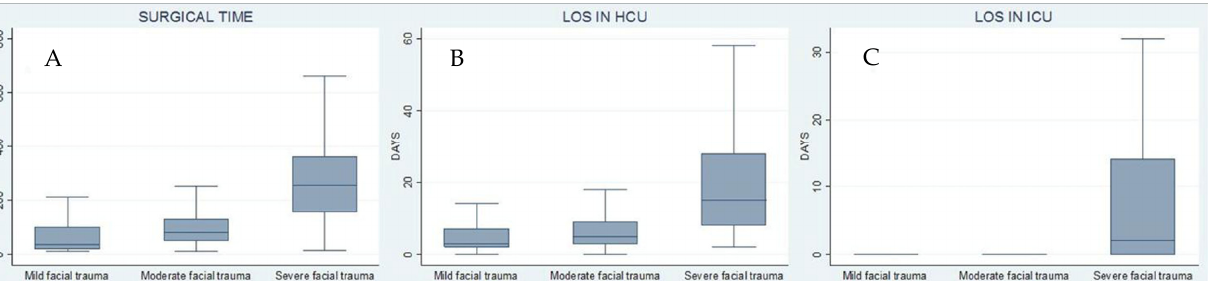
Figure 5. Box plots of overall surgical time ( A ), LOS in HCU ( B ), and LOS in ICU ( C ). Outside values are not represented. Box plots show the significant increase in overall surgical time ( A ) that exists between mild/moderate and severe facial trauma (according to a higher cutoff value established for CFI ≥ 10): none of the moderate classified patients reaches an overall surgical time ≥ 240 min. LOS in HCU ( B ) and LOS in ICU ( C ) results show a consensual trend, confirming the statistical goodness of the identified cutoff.